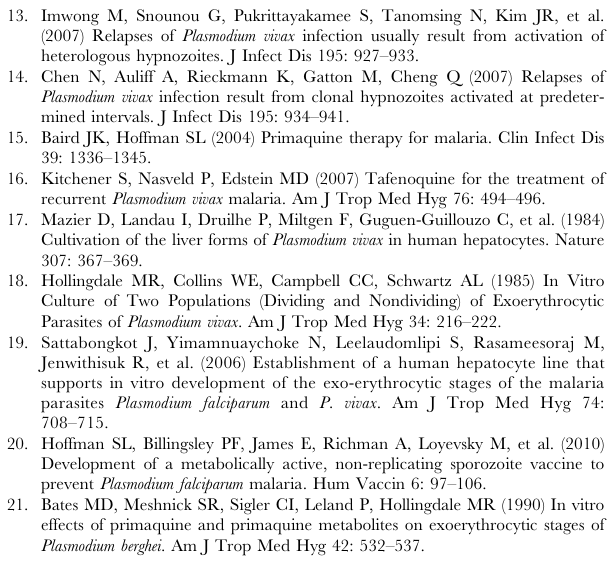
PQ Dose ( m g/mL) Pv Hepatocyte Stage